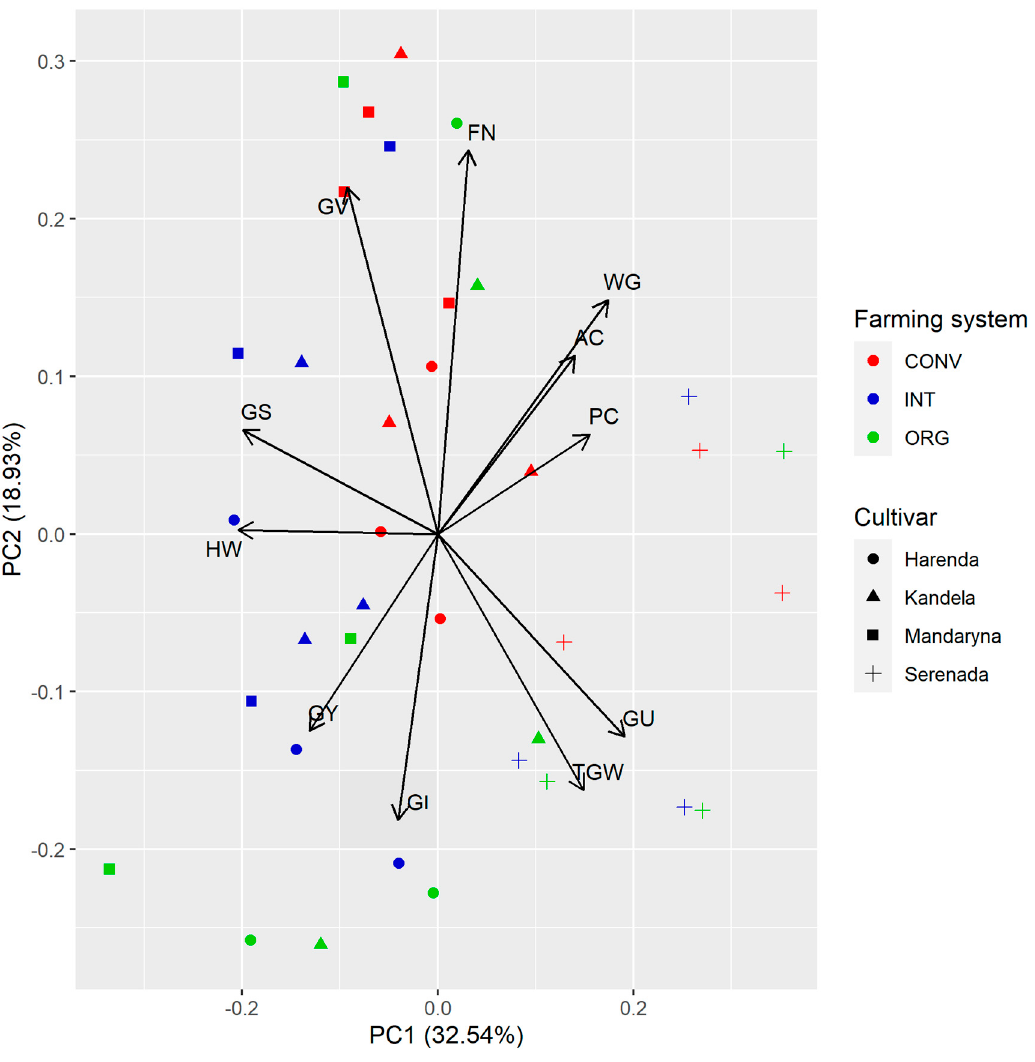
Figure 5. Biplot of PCA for all of the study traits. Abbreviations: HW—hectolitre weight, TGW—1000 grain weight, GS—grain selectivity, GU—grain uniformity, GV—grain vitreousness, AC—ash content, PC—protein content, WG—wet gluten, GI—gluten index, and FN—falling number.